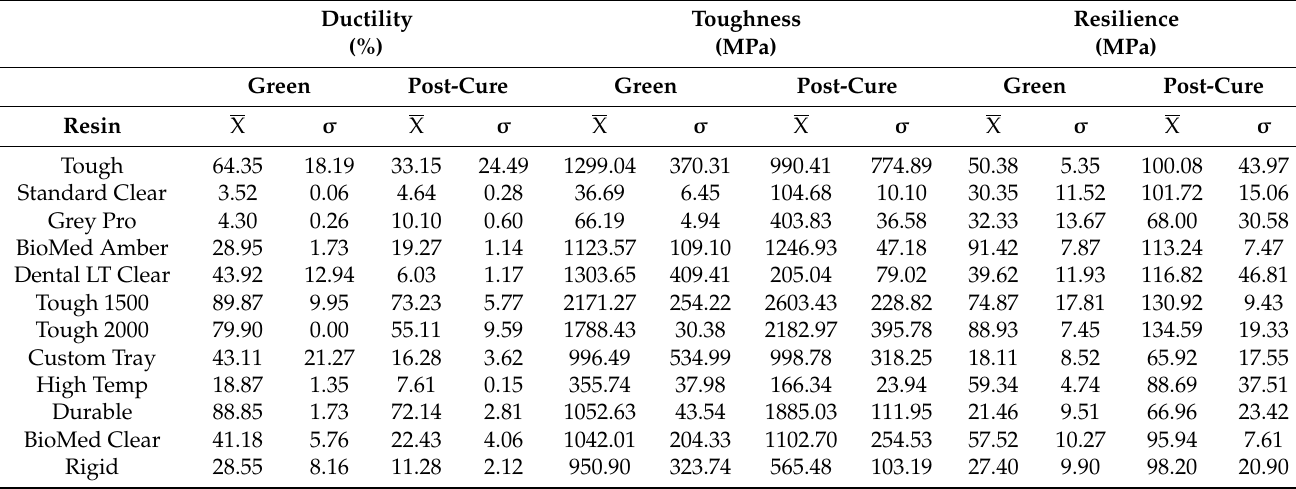
Table 3. Ductility, toughness, and resilience values as obtained for each resin. Comparison between green and post-cure conditions. Mean X and standard deviation values σ